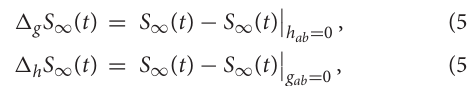
FIGURE 4 | Static-gain ERs calibrated to closely approximate typical S and D responses from Kerr et al. (2008), Kerr et al. (2011), and Babaie-Janvier and Robinson (2019), as indicated in the legend, which were used as benchmarks for the S and D responses (outlined in section 3.2). (A) Benchmark S and D curves used to ∞ derive gain modulations in Table 2 . (B) Corresponding MMN( D , S , t